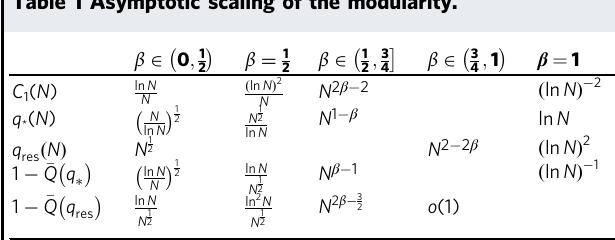
Table 1 Asymptotic scaling of the modularity.